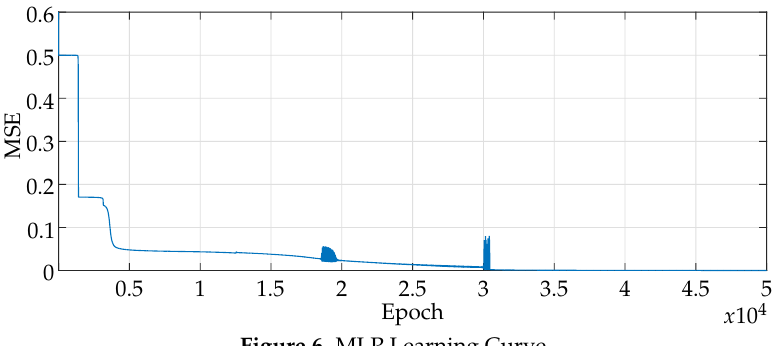
Figure 6. MLP Learning Curve.